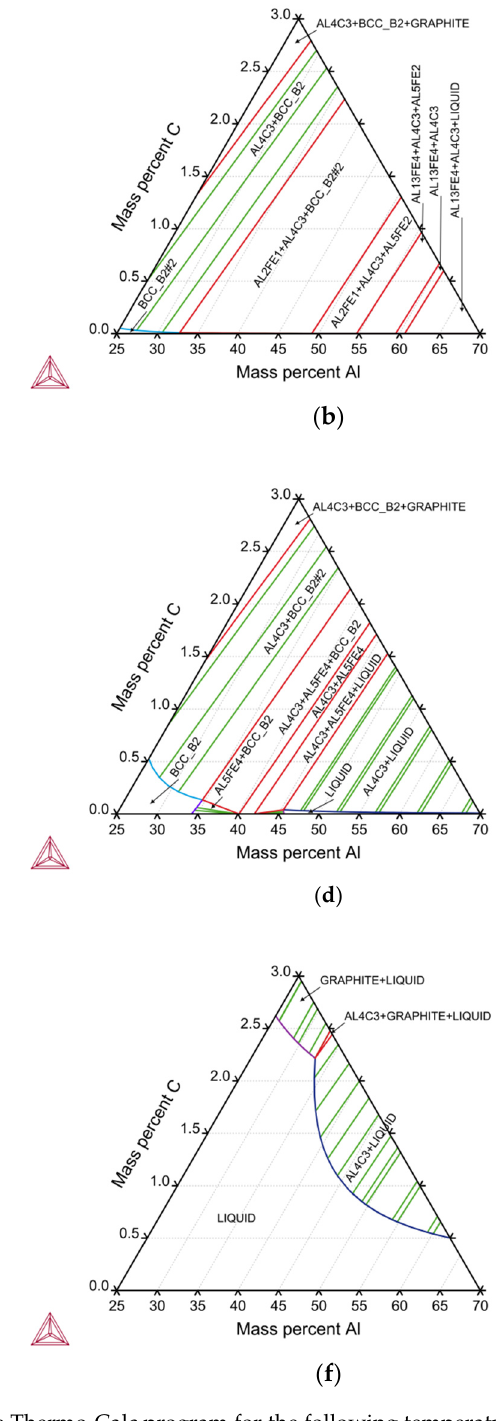
Figure 2. Phase equilibrium system of Al-Fe-C alloys obtained in the Thermo-Calc program for the following temperatures: 600 °C ( a ), 800 °C ( b ), 1000 °C ( c ), 1200 °C ( d ), 1400 °C ( e ), 1600 °C ( f ). Possible is to separate carbon in the form of graphite, starting from the carbon content of 2.5% ( b – f ).